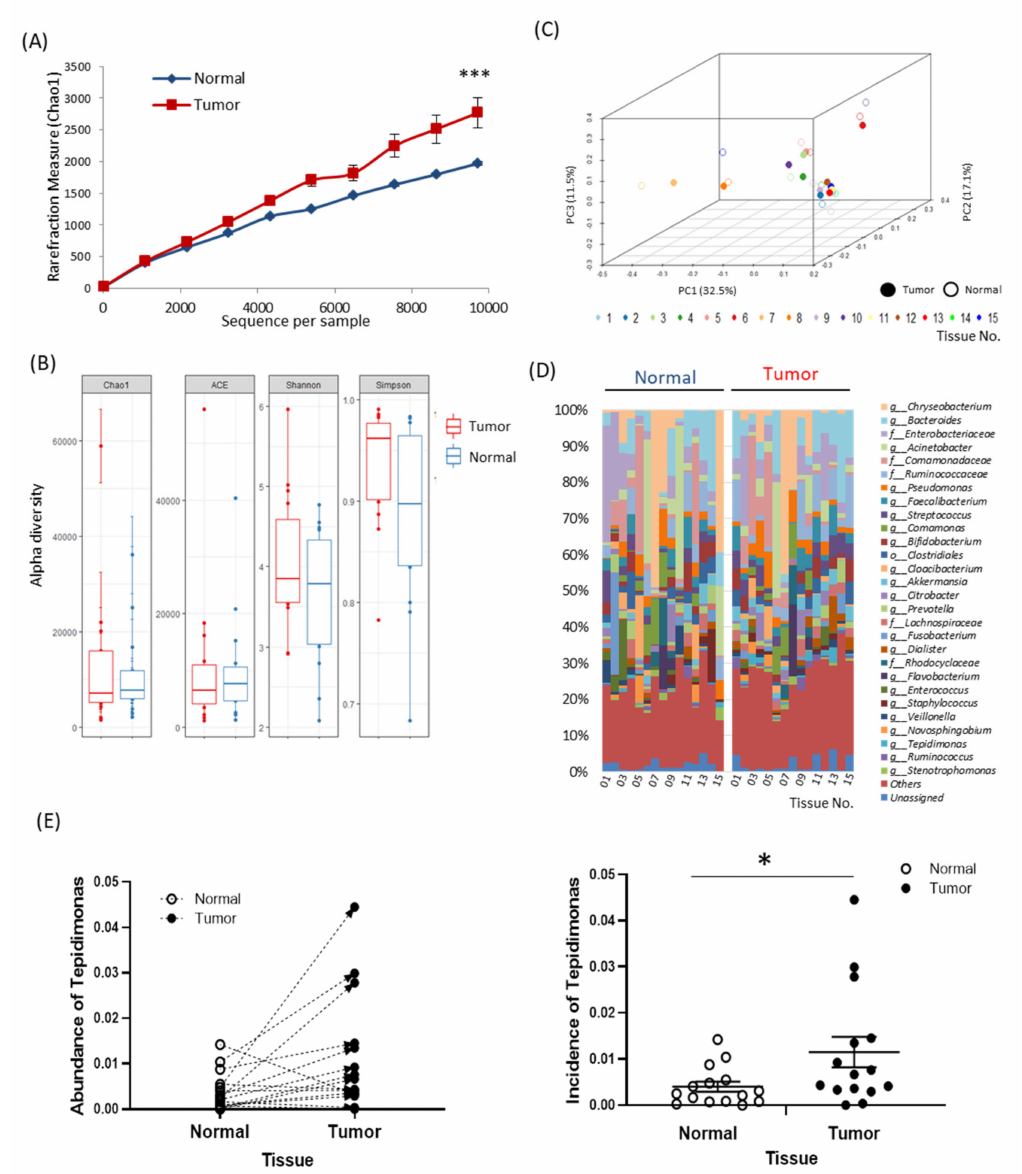
Figure 1. Characterization of extracellular vesicles (EVs) in the tissues of patients with pancreatic cancer and microbiome composition profiling: ( A ) alpha diversity rarefaction plots for the EV-derived microbiomes in tumor and normal tissues ( n = 15, mean ± SEM, *** p < 0.001), ( B ) comparison of alpha diversity indices between tumor and normal tissues ( n = 15), ( C ) beta diversity of EV-derived microbiomes in 3-dimension in tumor and normal tissues ( n = 15), ( D ) common microbiota in paired normal and tumor tissues at the genus level ( n = 15), and ( E ) abundance of Tepidimonas in tumor and normal tissues ( n = 15, mean ± SEM, * p <